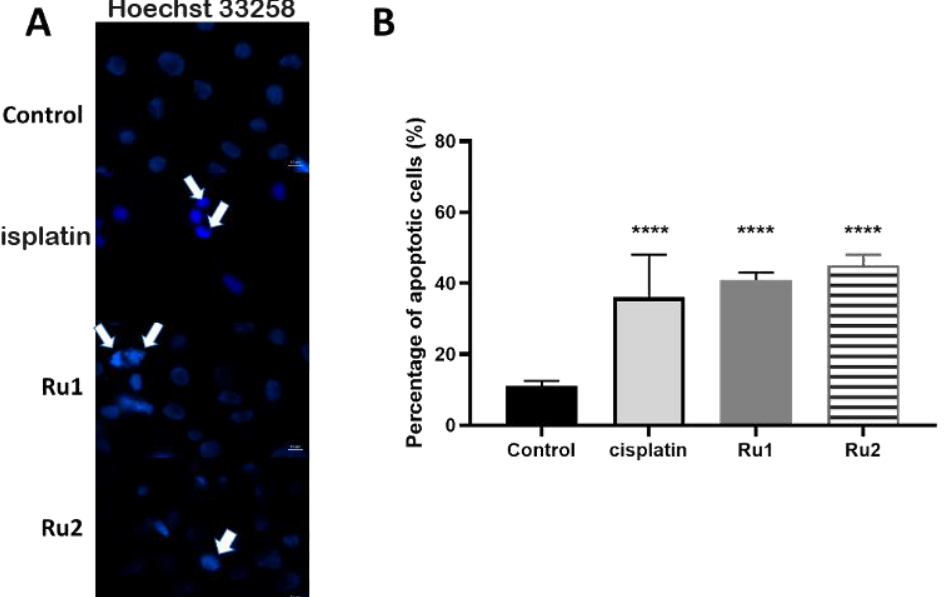
Figure 4. ( A ) Hoechst staining (excitation and fluorescence emission at 352 and 461 nm, respectively) of MCF7 cell line for visualization of apoptotic nuclei. Cells were grown in DMEM culture medium supplemented with 10% ( v / v ) fetal bovine serum in the presence of 0.1% ( v / v ) DMSO, the IC 50 of cisplatin, the IC 50 of Ru1 , or the IC 50 of Ru2 for 72 h. The arrows indicate an initial event of apoptosis such as chromatin condensation and nuclear fragmentation. The images were acquired using a ZEISS Microscope with ZEN software. ( B ) Percentage of apoptotic cells in MCF7 breast adenocarcinoma cell line after exposure to 0.1% ( v / v ) DMSO (vehicle control) or to the IC 50 of each Ru(II) compound. The data are presented as the mean ± SEM of three independent experiments, and the statistical significance was evaluated in relation to the reference group (control) using the one-way ANOVA method followed by a Tukey multiple comparison test (**** p ≤ 0.0001).